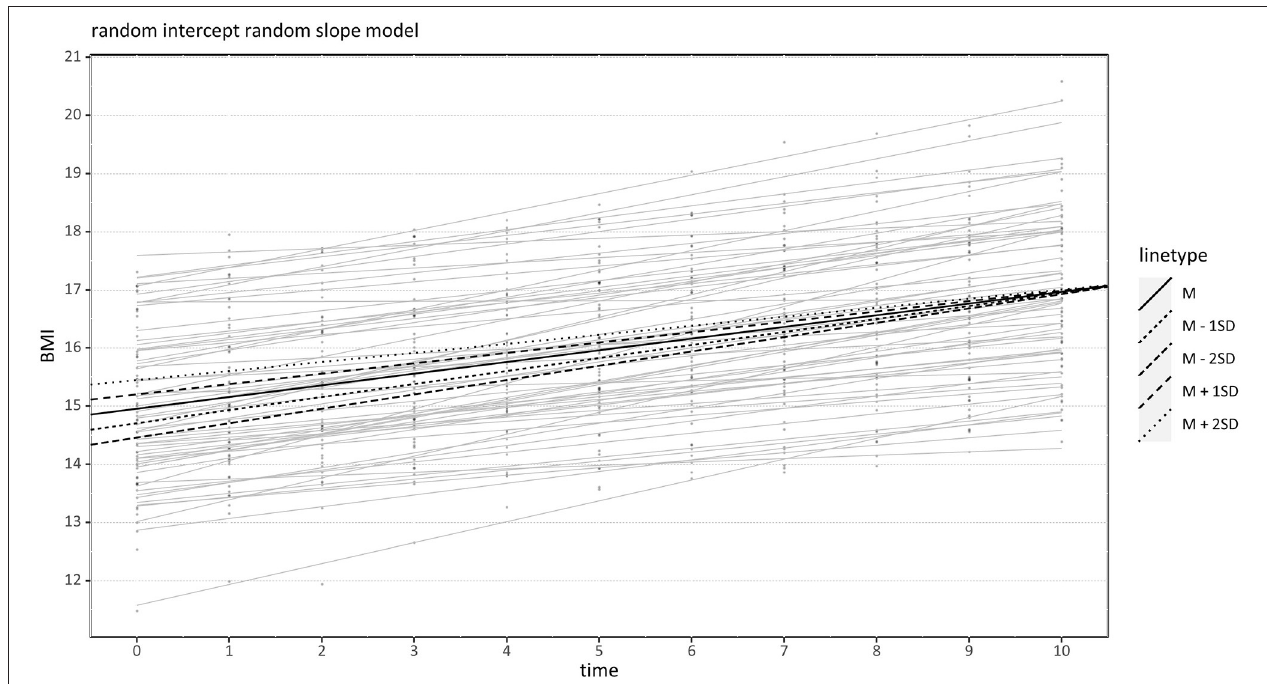
FIGURE 1 | Effect of Assessment of Identity Development in Adolescence (AIDA) on BMI Increase over Time. Black lines indicate conditional regression lines for very low ( M − 2 SD ), low ( M − 1 SD ), medium ( M ), high ( M + 1 SD ), and very high ( M + 2 SD ) AIDA scores. BMI, Body mass index.